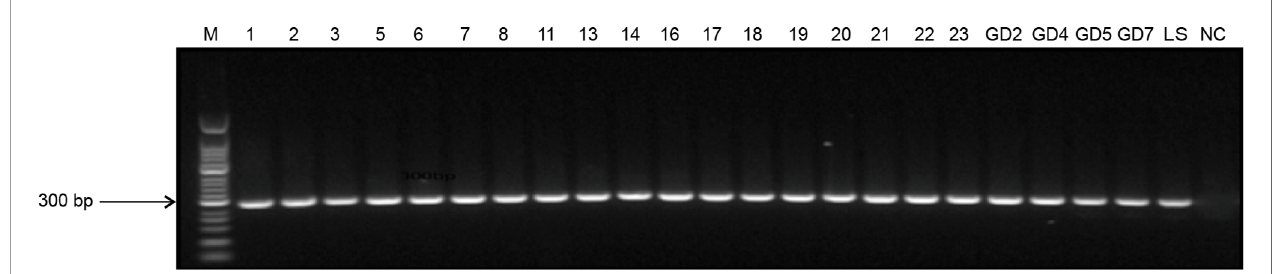
FIGURE 2 | Nested PCR ampli fi cation of ITS genes from Leishmania species. M, 50-bp DNA marker; 1 – 23, DNA extracted from patient blood samples and samples from their family members; GD2 – GD7, DNA extracted from animal tissues of pigs; LS, positive control; NC, negative control.